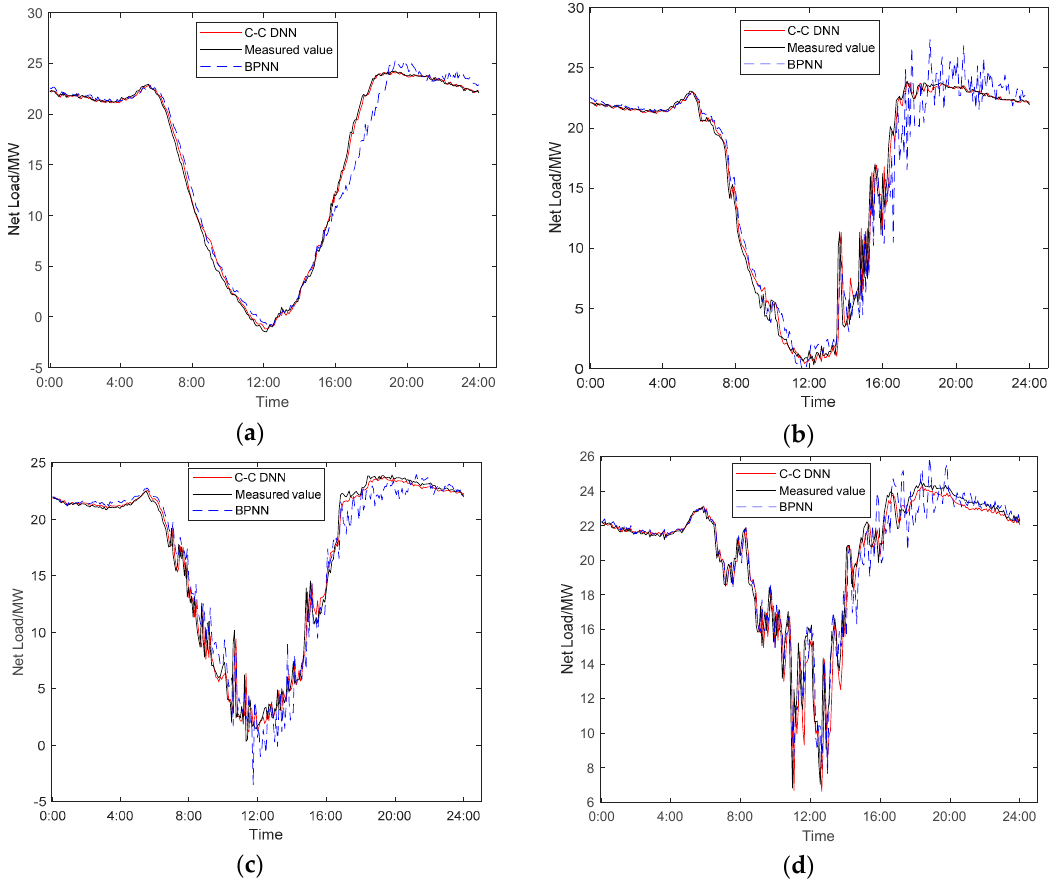
Figure 5. Load forecasting results based on different models: ( a ) 12 May; ( b ) 13 May; ( c ) 14 May; ( d ) 15